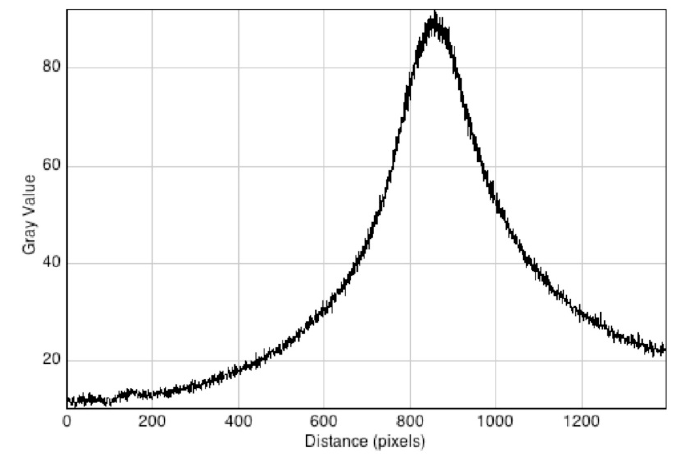
Figure 16. A pixel profile scan taken along the axis of the catheter, i.e., the centralvertical axis in Figure 15. The pixel resolution is 0.035 mm/pixel with a total scan length of approximately 50 mm.